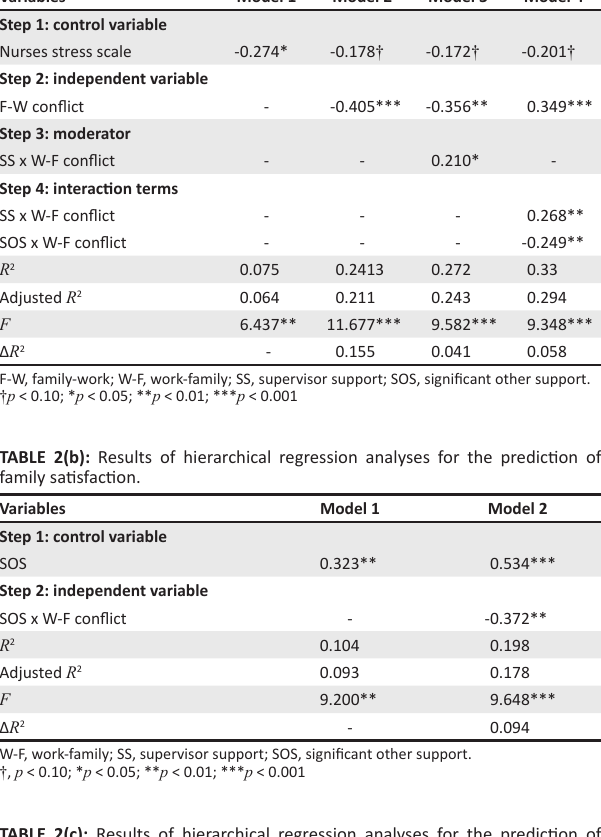
TABLE 2(c): Results of hierarchical regression analyses for the prediction of turnover intentions.